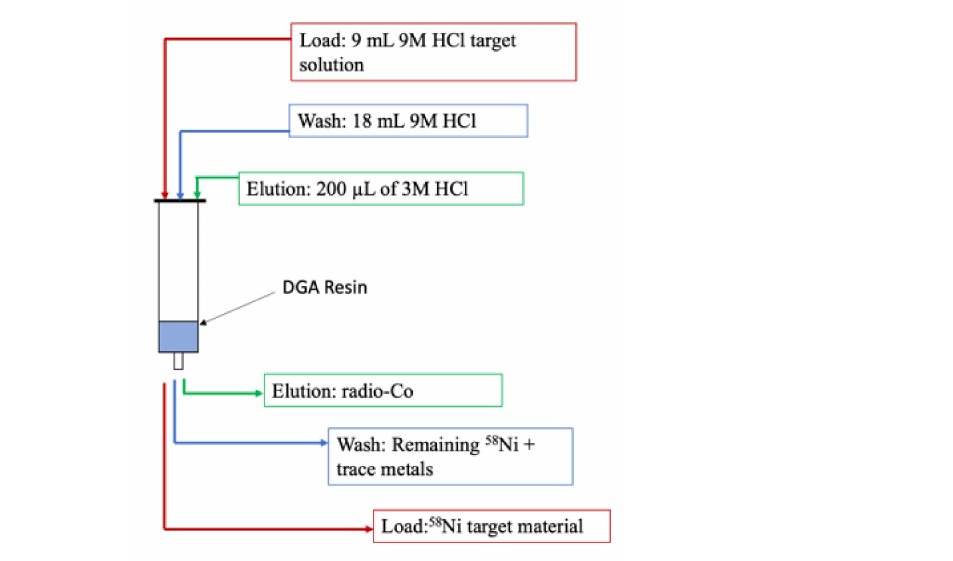
Figure 17. Flow diagram of the one-column method for the separation of cobalt-5x from nickel.